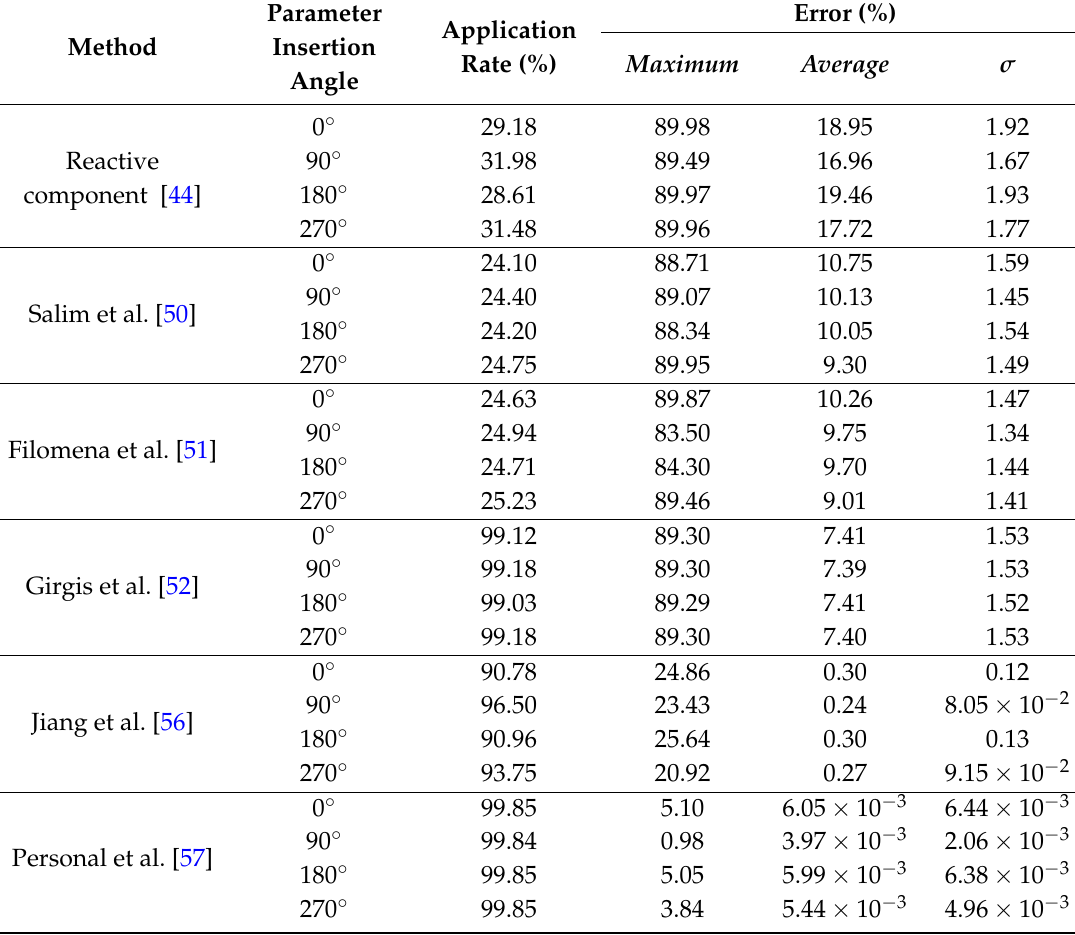
Table A2. Insertion angle analysis.